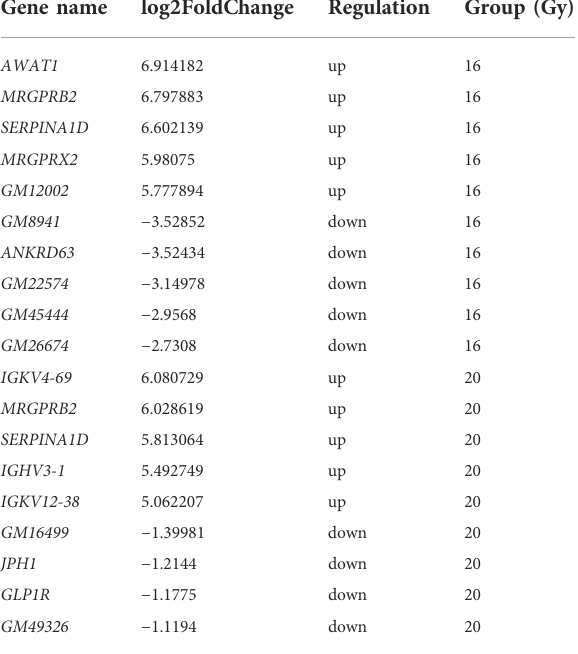
TABLE 2 Top 5 Signi fi cantly Up- and Downregulated mRNAs in the radiation groups at 6